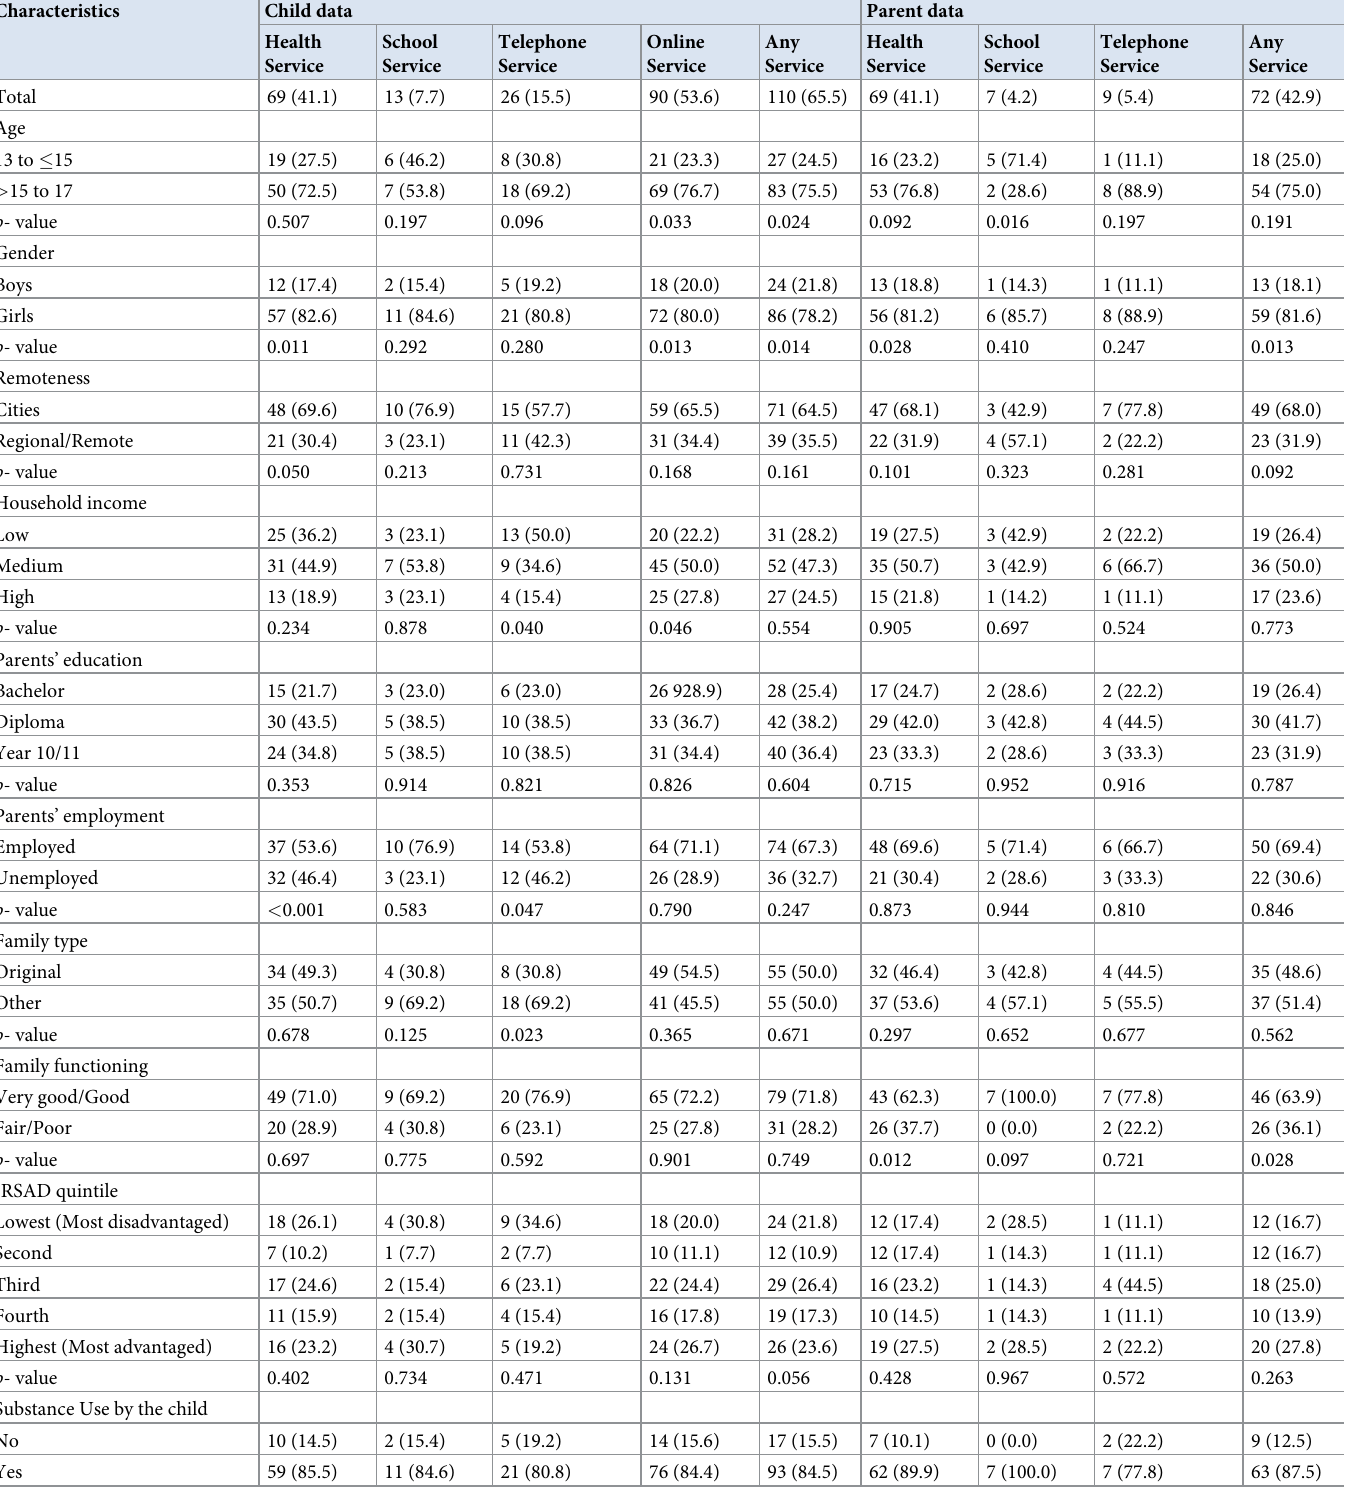
Table 4. Bivariate analysis between mental health services and sociodemographic factors in adolescents with suicidality (n = 168).